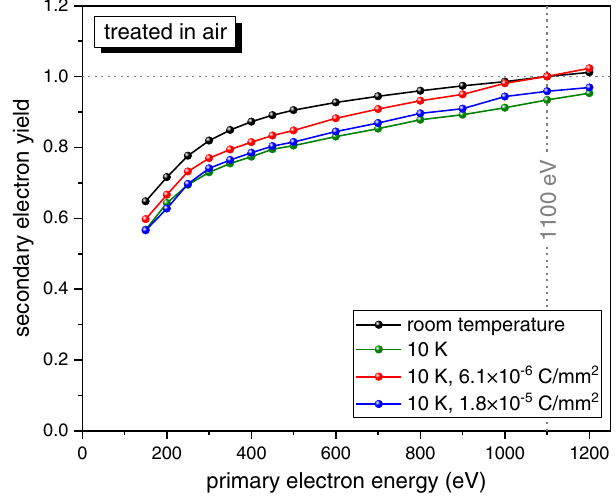
FIG. 8. SEY measurements of a LH-patterned sample treated in nitrogen atmosphere: at room temperature (black line), at ≈ 10 K (green line), and after exposure to an electron dose of 6 . 1 × 10 − 6 (red line) and 1 . 8 × 10 − 5 C mm − 2 (blue line).